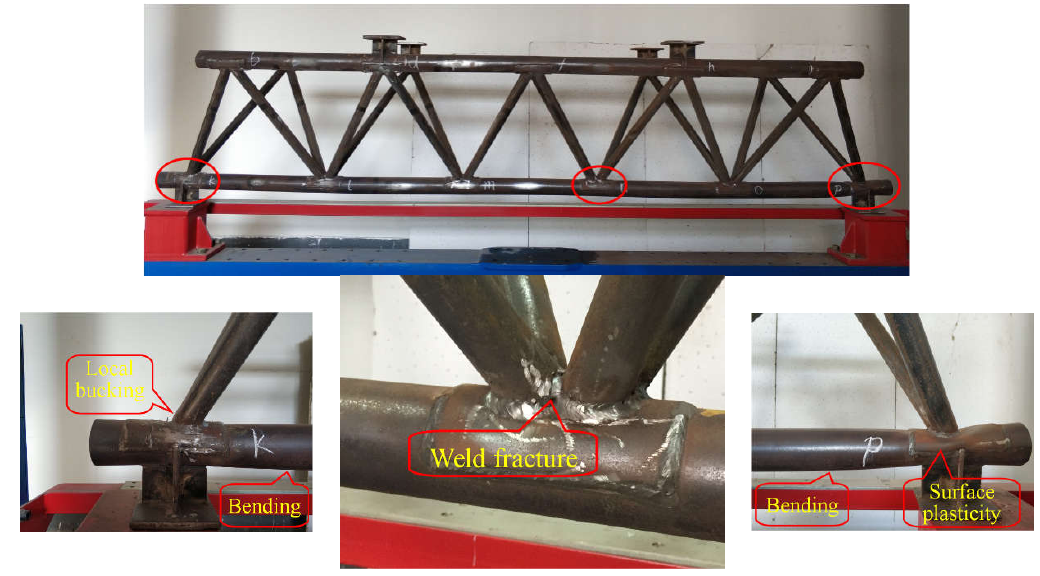
Figure 7. Failure modes of specimen TS-AS.